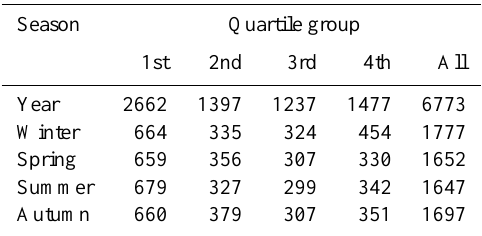
Table 1. Number of storms, considering different seasons and